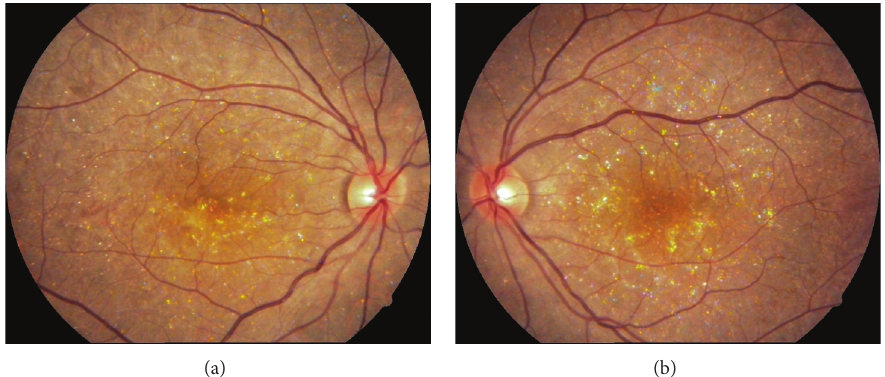
Figure 1: Color fundus pictures depicting the intraretinal crystals. (a) Right eye and (b) left eye.